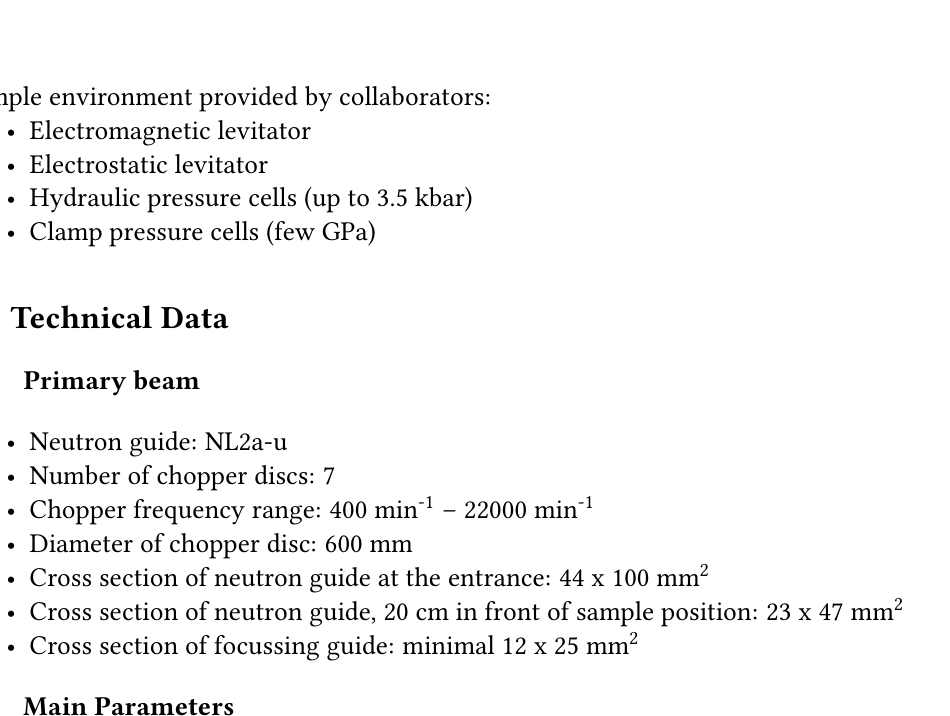
Figure 2: Schematic drawing of